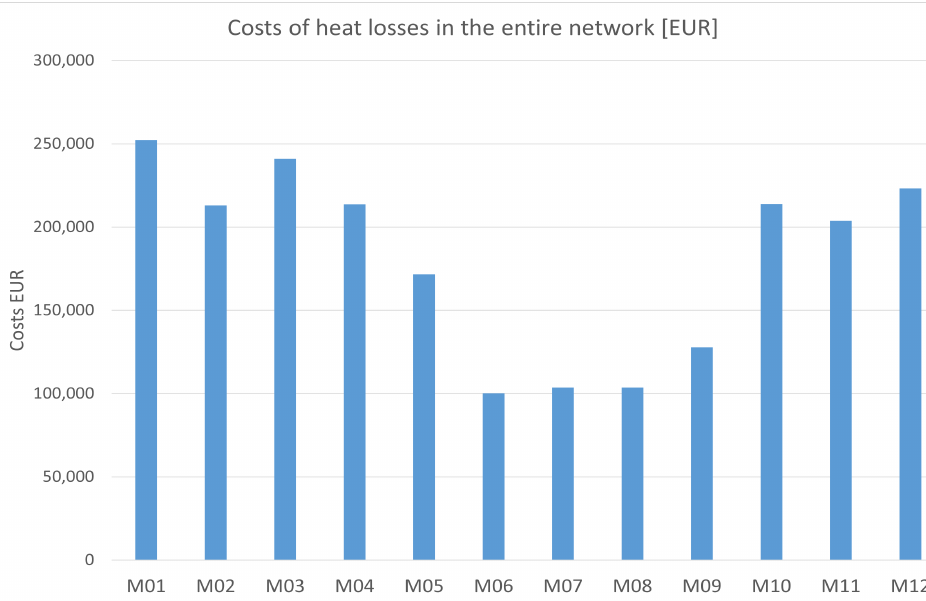
Figure 6. Estimated costs of heat losses in the heating network in consecutive